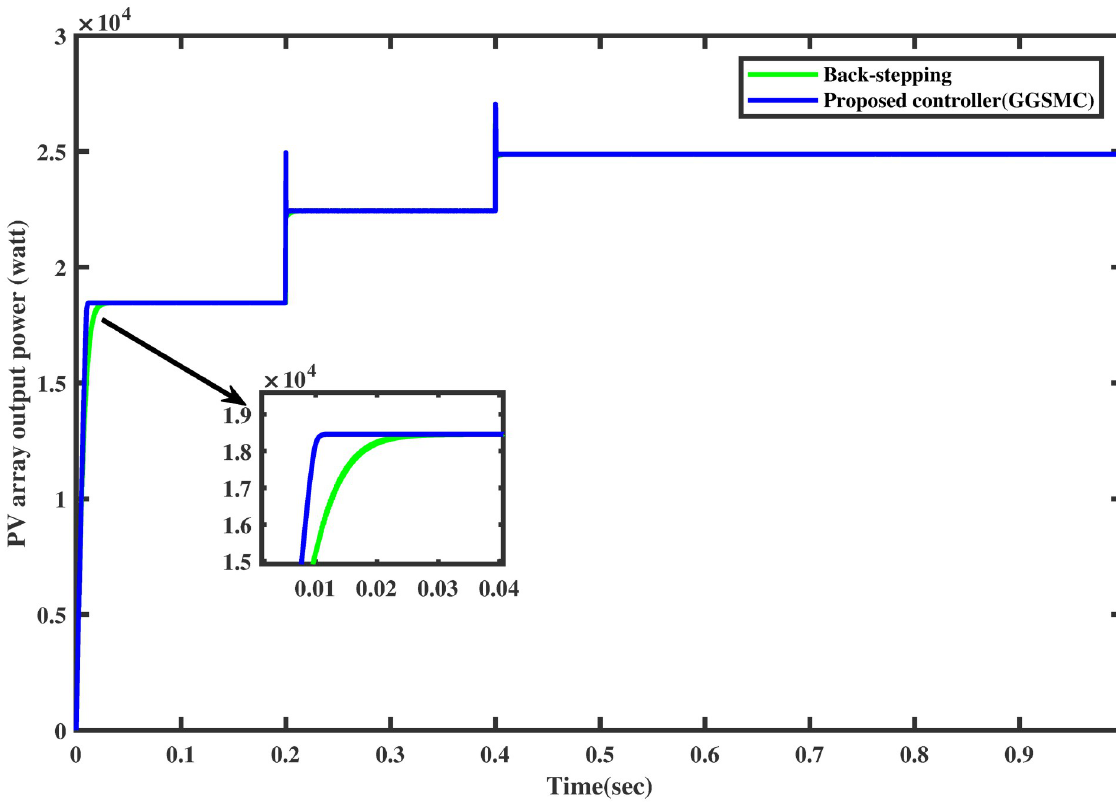
Fig 19. Comparison of PV array output power under varying